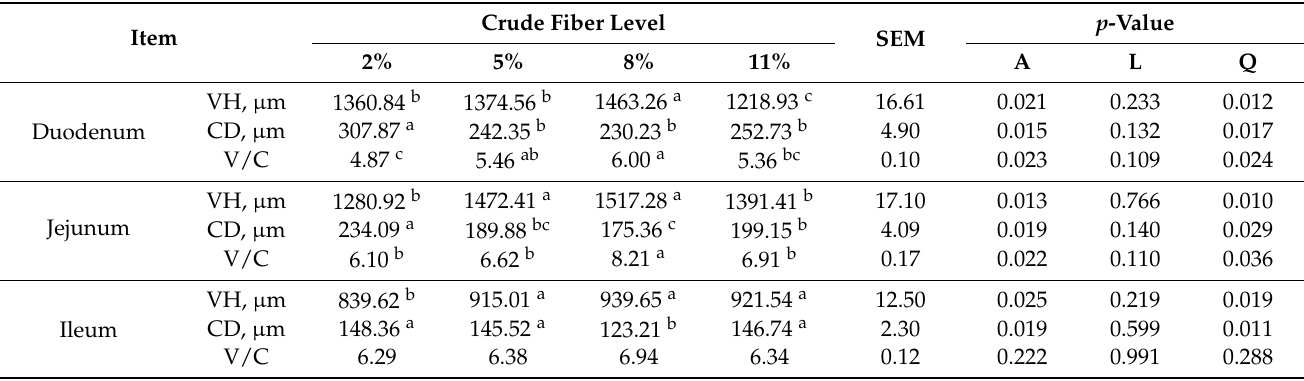
Table 7. Effect of dietary CF level on intestinal morphology of broilers on day 42.